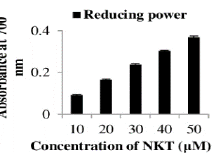
Figure 10. The in vitro reducing power of NKT. The columns are the average of experiments in triplicate.